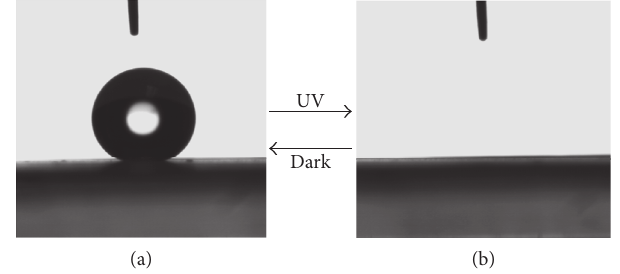
Figure 3: The shape of water droplet on the ZnO nanorod arrays (a) before UV irradiation and (b) after UV irradiation.